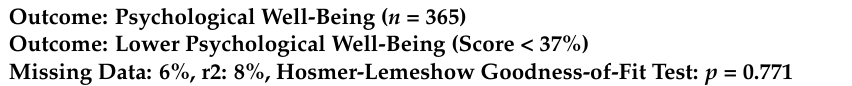
Table 5. Multivariate logistic regression: psychological well-being. Outcome: Psychological Well-Being ( n =